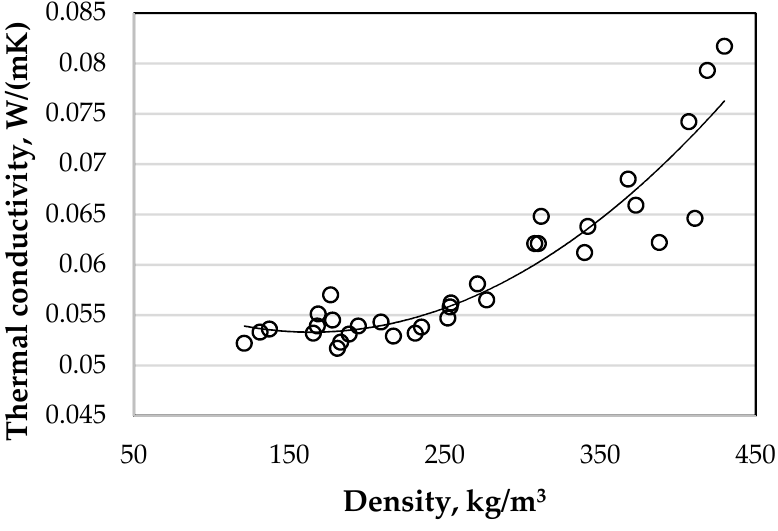
Figure 7. Dependence of the thermal conductivity of the biocomposite on its density. Increasing the amount of sapropel in the biocomposite mixture is of relatively minor importance. By increasing the amount of sapropel in the mixture three times, the thermal conductivity of the cured biocomposite increases only from 1.5% to 10.1%. Additionally, increasing the amount of sapropel is more important for the biocomposites made from the fraction 0/5 mm. For the biocomposites made from the 0/10 fraction, the maximum increase in thermal conductivity is observed by 9.3%, and for biocomposites from the 0/20 fraction, only